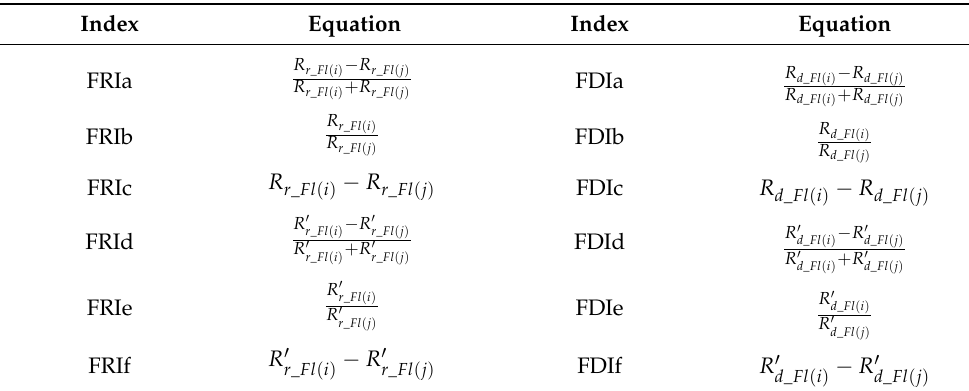
Table 2. Florescence indices tested in this